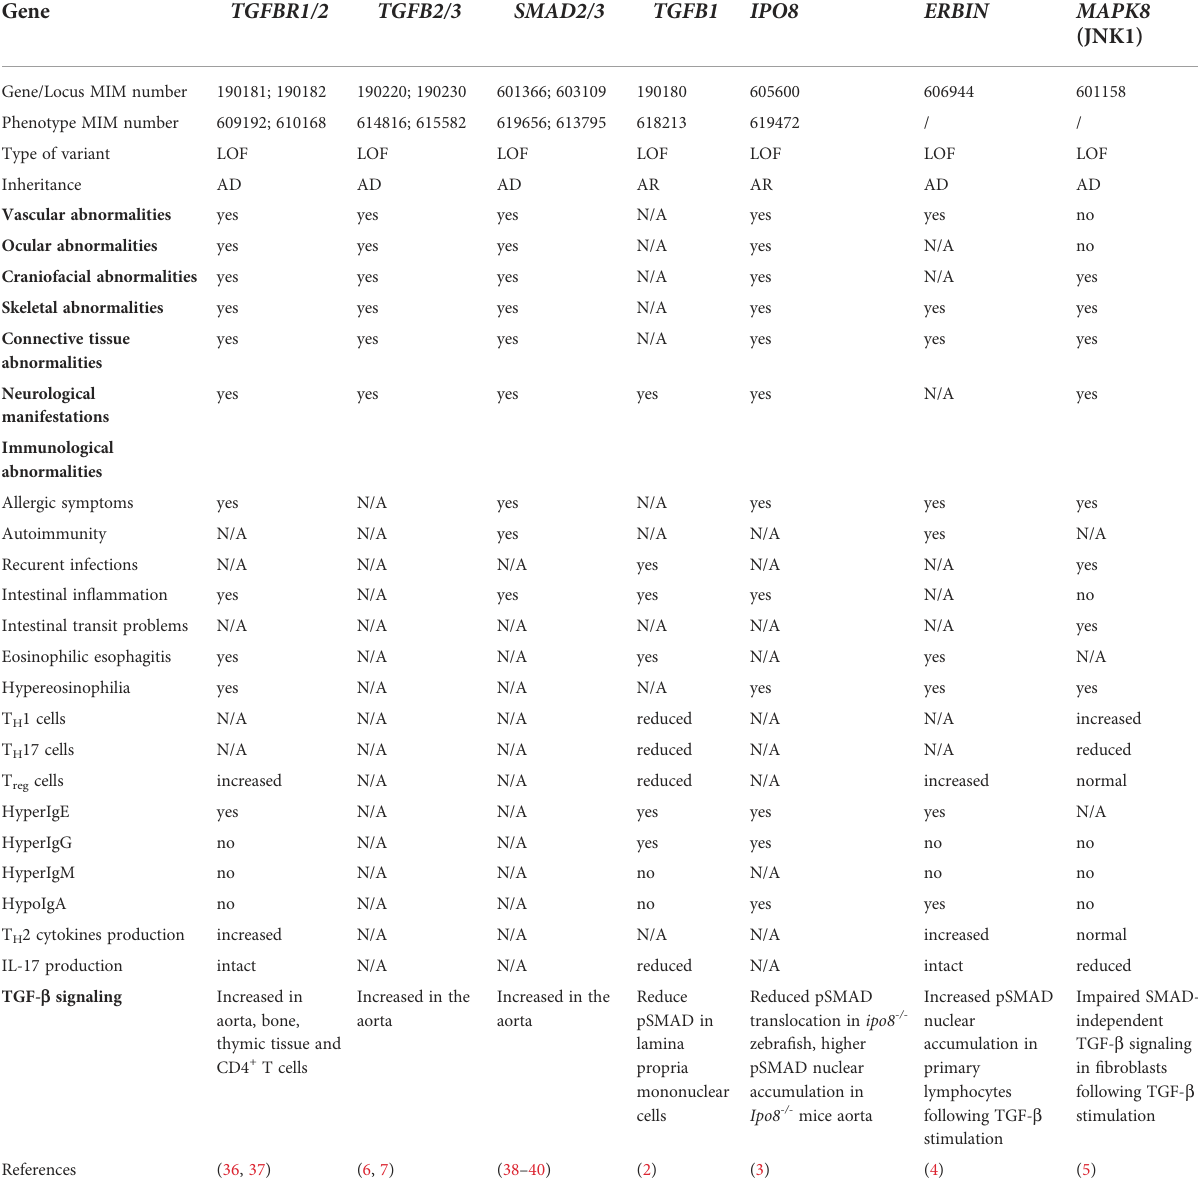
TABLE 1 Clinical features presenting in patients with TGF- b